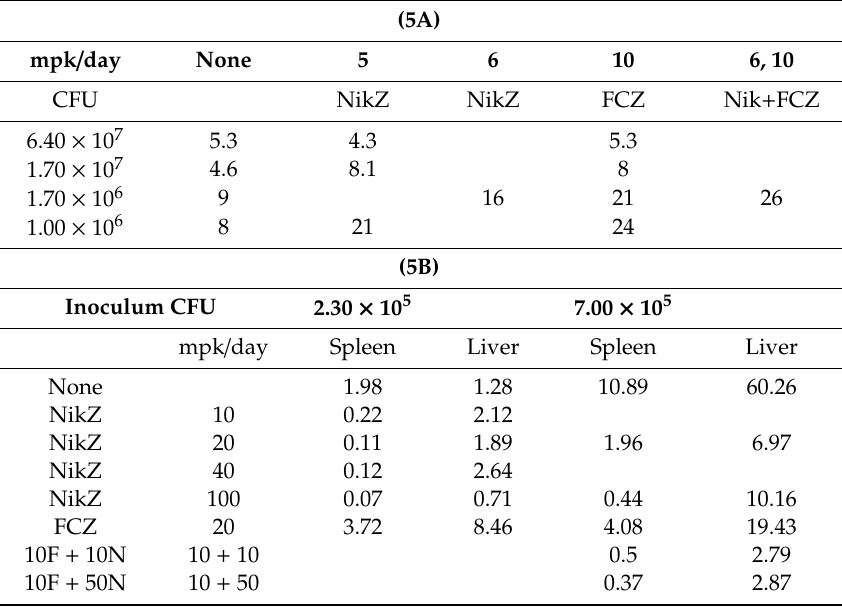
Table 5. IV disseminated histoplasmosis ( 5A ) inoculum finding, days mean survival, ICR mice, inoculated IV, after 2 days treat BID for 10 days, hold to 30 days, ( 5B ) organ burden. ICR mice, inoculate, after 2 days treat BID for 7 days, hold 1 more day